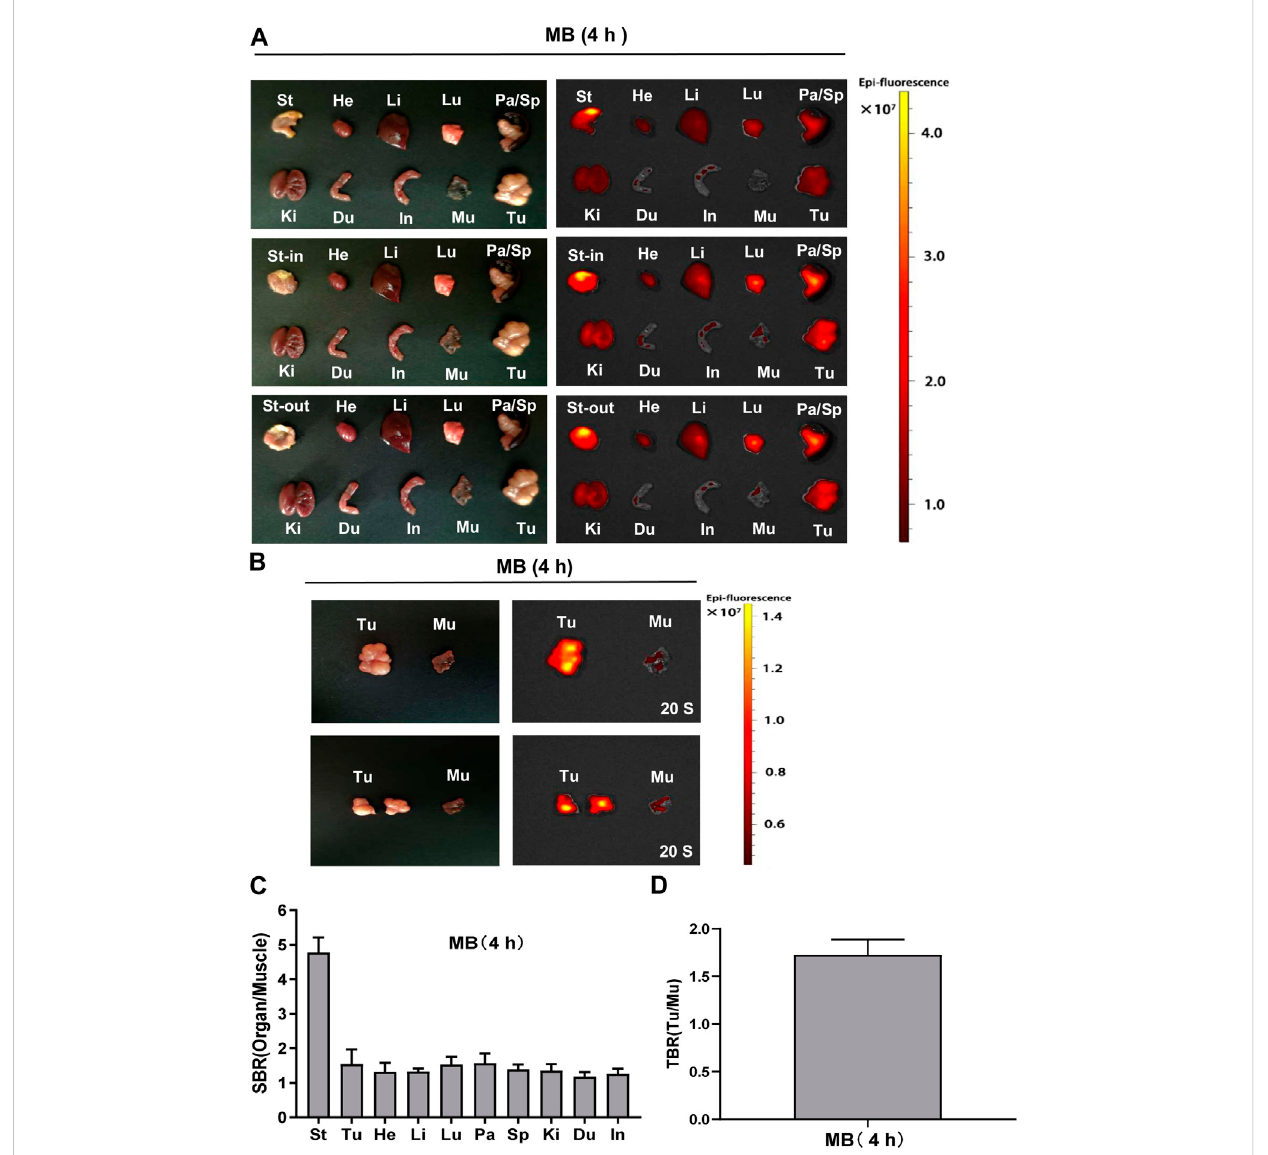
FIGURE 6 Organandtumorspeci fi cityofMBat4 hpost-injection.MBwasinjectedintravenouslyintosubcutaneousgastrictumor-bearingnudemice,andthe NIR fl uorescence signals were observed at 4 h post-injection under the NIR imaging system. (A) NIR imaging of resected major organs and tumor at 4 h post-injection of MB. (B) NIR imaging of resected tumor at 4 h post-injection of MB. (C) SBR of each organ against muscle. SBR was calculated by comparing the signals of major organs against the surrounding muscle. (D) Tumor-to-background ratio (TBR) of resected tumors. TBR was calculatedbycomparingthesignalsofthetumoragainstthesurroundingmuscle.AbbreviationsareDu,duodenum;He,Heart;In,intestine;Ki,kidneys;Li, liver;Lu,lungs;Mu,muscle;Pa,pancreas;Sp,spleen;St,stomach;St-in,stomach-in;St-out,stomach-out;Tu,tumor.Eachsampleusedthreemice.Error bars show mean ±